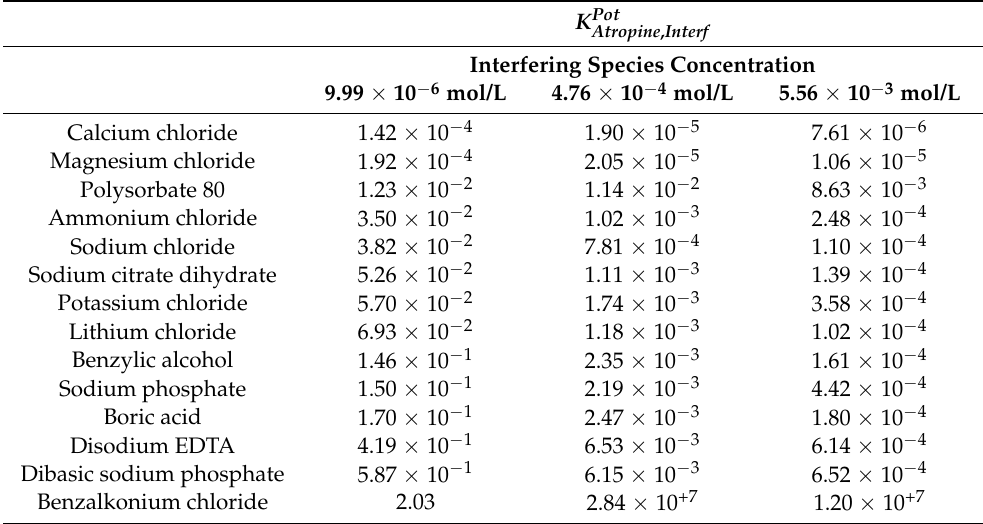
for the atropine-selective Atropine , Interf